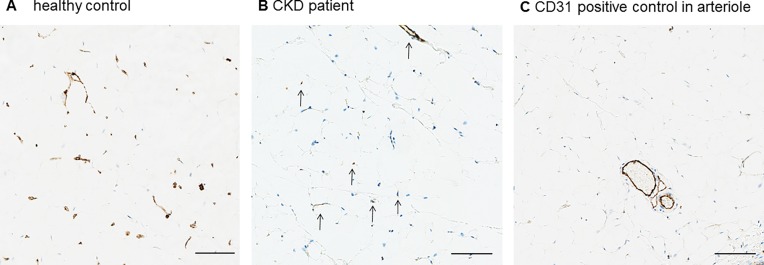
Capillary staining in omental tissue.Representative sample of omental tissue of a control child (A) and a child with CKD 5 (B). A positive control for the CD31 stain (C) is shown in a larger arteriole, venule and lymphatic vessel. Scale bars: 100μm.